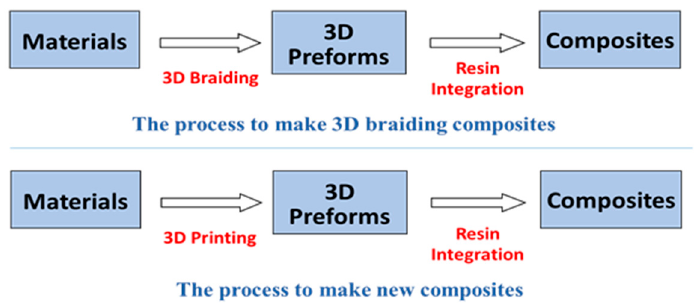
Figure 2. Comparison of classical and new processes to fabricate composites.